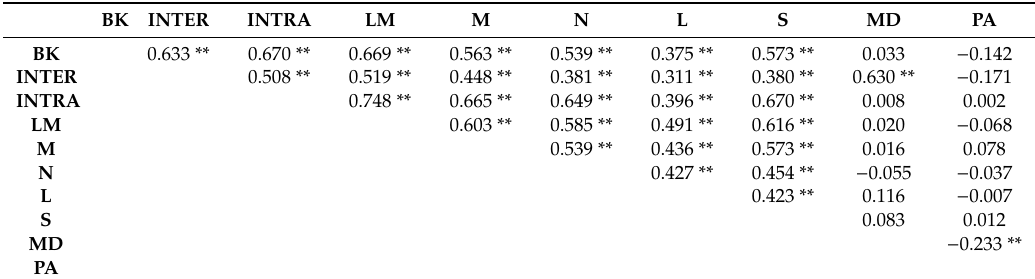
Table 2. Bivariate correlations between multiple intelligences, PA, and MD for females.